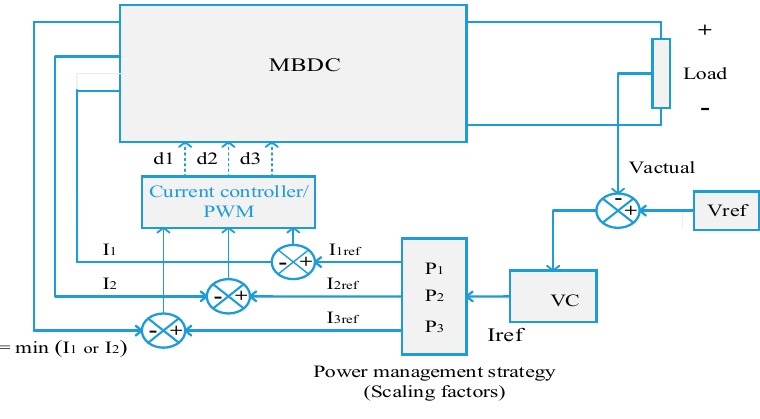
Figure 6. Power control strategy for the MBDC converter.